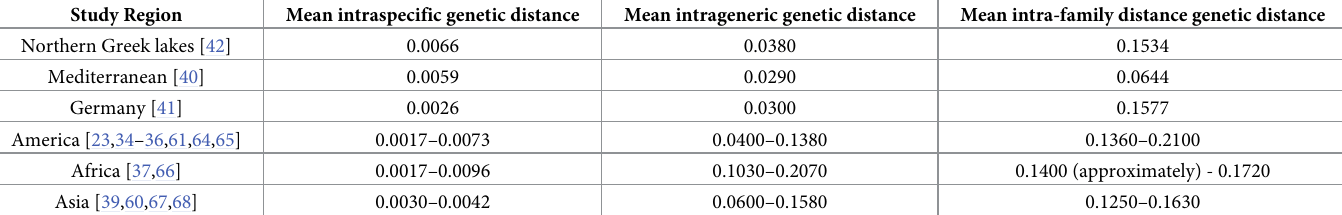
Table 2. Mean intraspecific and intrageneric genetic distances from broad scale studies. In the first column the area covered by the study is given, followed by the study reference. Study